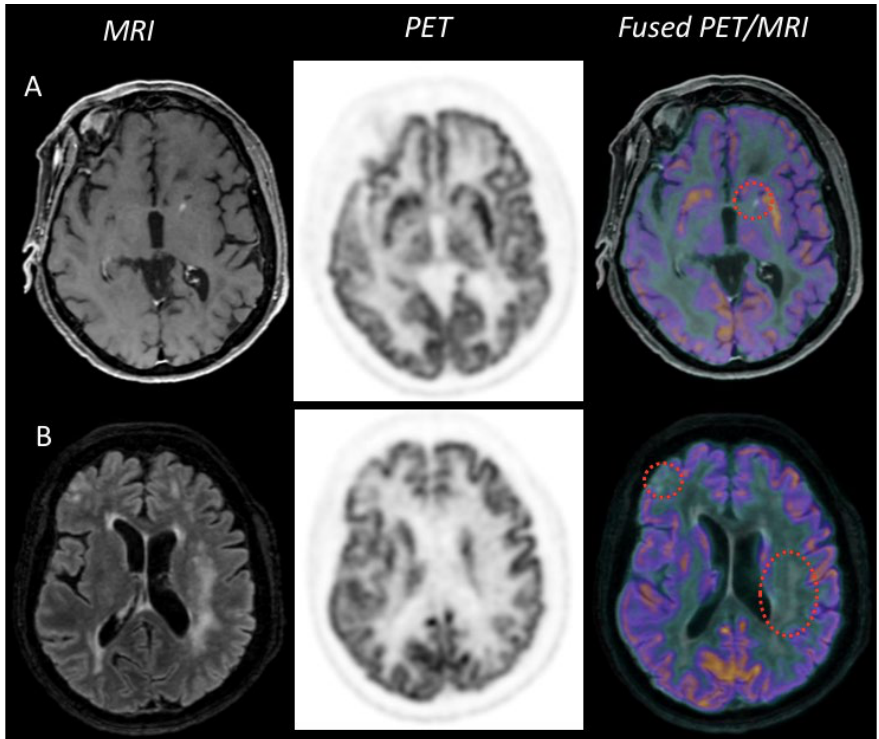
Figure 3. Example case of PET-MRI images of an intravascular lymphoma. Gadolinium-weighted T1+ imaging ( A ) showed a small enhanced punctiform lesion in the medial part of the left striatum, with no metabolic uptake on 18 F-FDG PET images. The cortical and subcortical lesions in FLAIR hypersignal ( B ) did not show uptake with 18 F-FDG either.